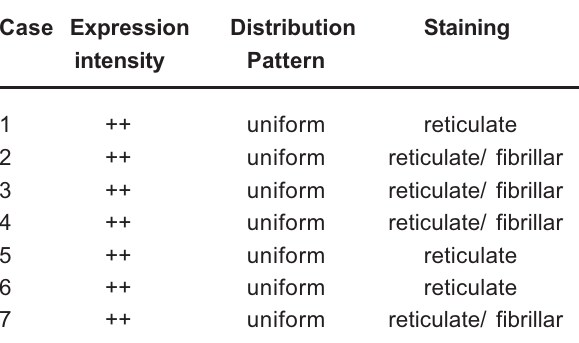
TABLE 4 - Tenascin expression intensity, distribution and staining pattern in interstitial extracellular matrix of the giant cell tumors of long